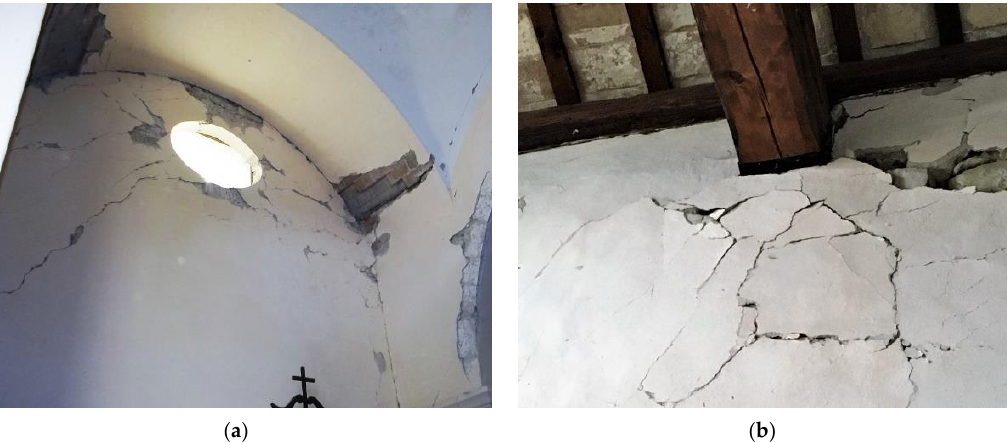
Figure 20. Other mechanisms activated in the wall: ( a ) shear mechanism in the lateral walls in St. Giovenale church in Roccasalli (C25); ( b ) roof covering mechanism in in St. Elpidio church in Campli (C9).